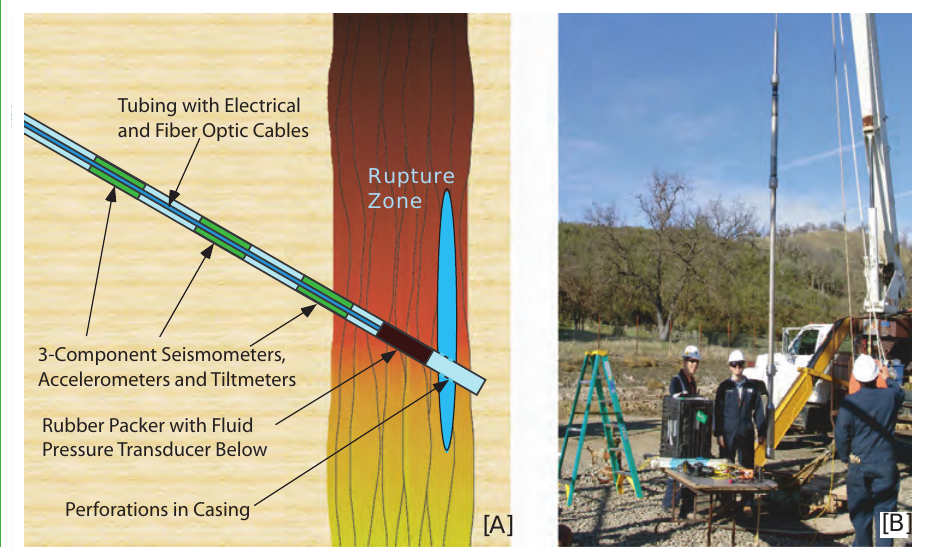
Figure 4. [A] Schematic of the long-term monitoring array for SAFOD. After casing is cemented in place from the bottom of corehole 3 to the surface (see Fig. 2B), the casing will be perforated in the fault zone, and the array will be emplaced on rigid tubing close to the target earthquake rupture zone. This array is designed so that it can be periodically removed for maintenance and repair. Unidirectional bow-springs (not shown) decentralize the seismic sensors to insure good coupling with the casing, and a rubber packer is inflated just above the perforations to monitor variations in fluid pressure during the earthquake cycle. [B] Engineers from Pinnacle Technologies testing a prototype for the seismic and tilt sensors in the SAFOD borehole following Phase 2 drilling. Photo taken by Peter